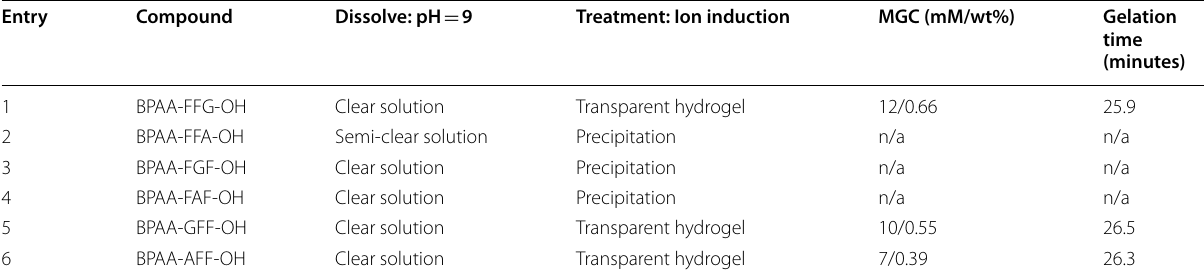
Table 1 Gelation properties of BPAAtripeptide compounds